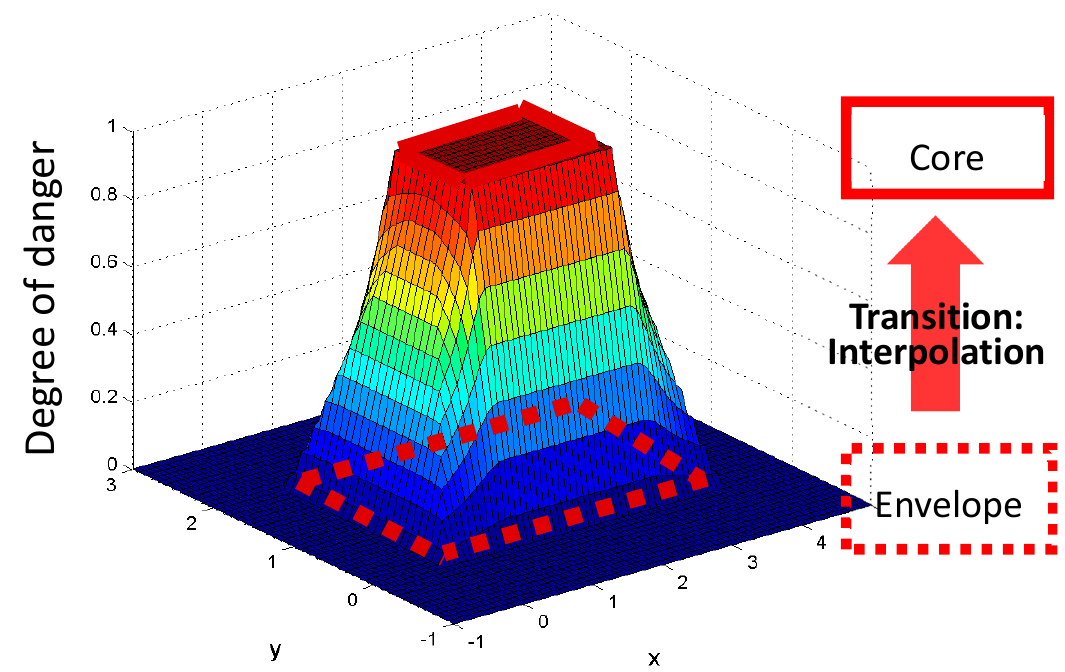
Figure 4. Linear modeling in detail of the degree of danger of a particular hazard.